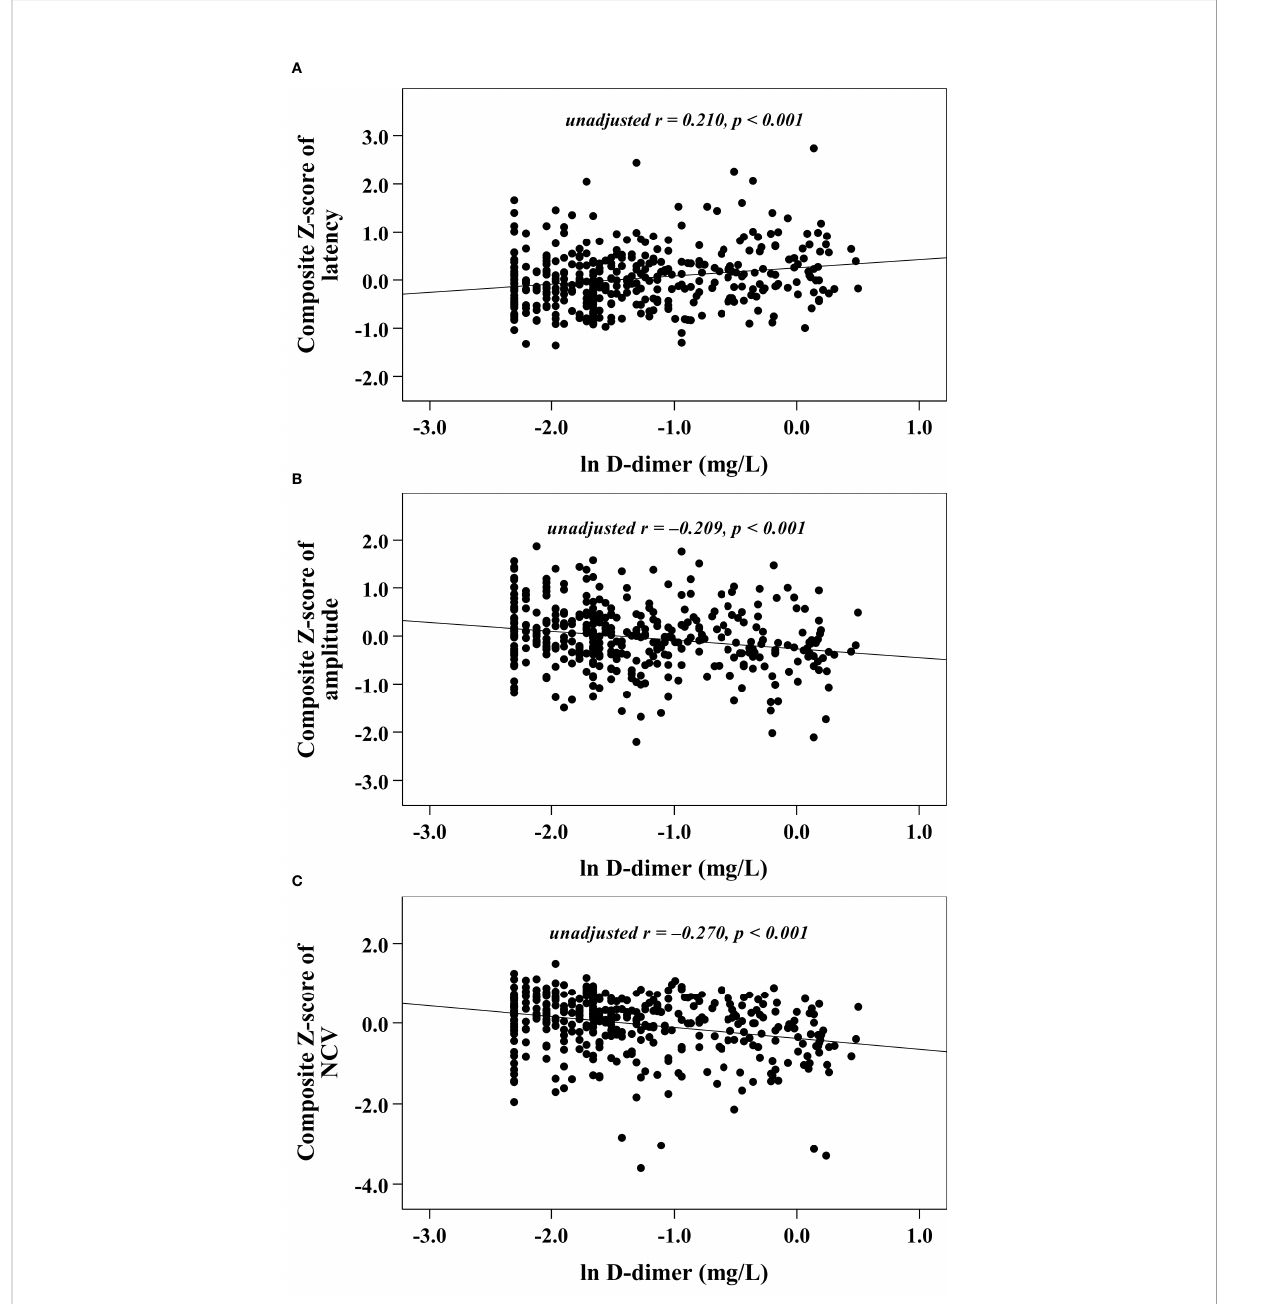
FIGURE 1 Graphically exhibited correlations between D-dimer and nerve conduction indices ( A: composite Z score of latency; B: composite Z score of amplitude; C: composite Z score of